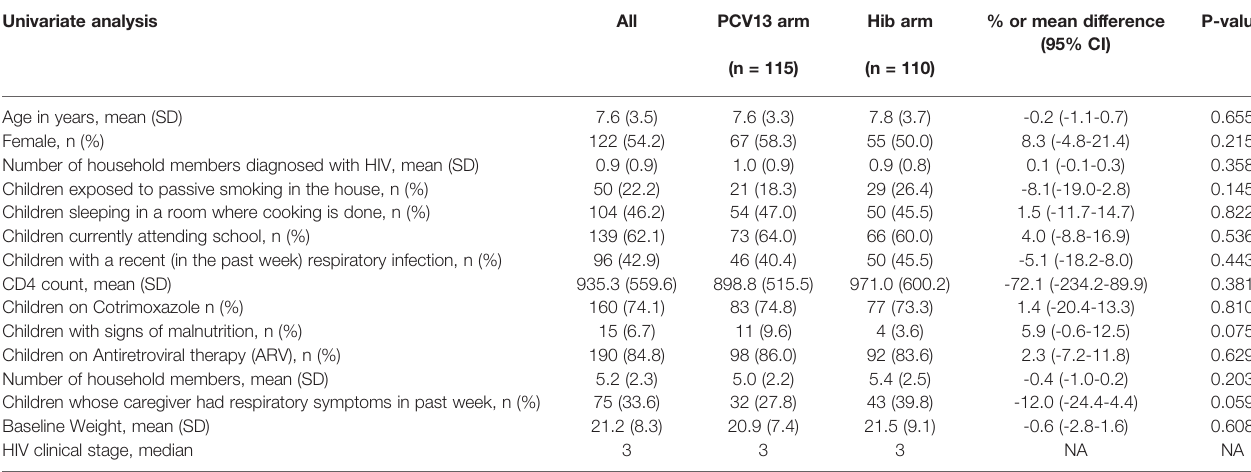
TABLE 1 | Comparison of demographic and clinical characteristics of participants in two study arms. Univariate